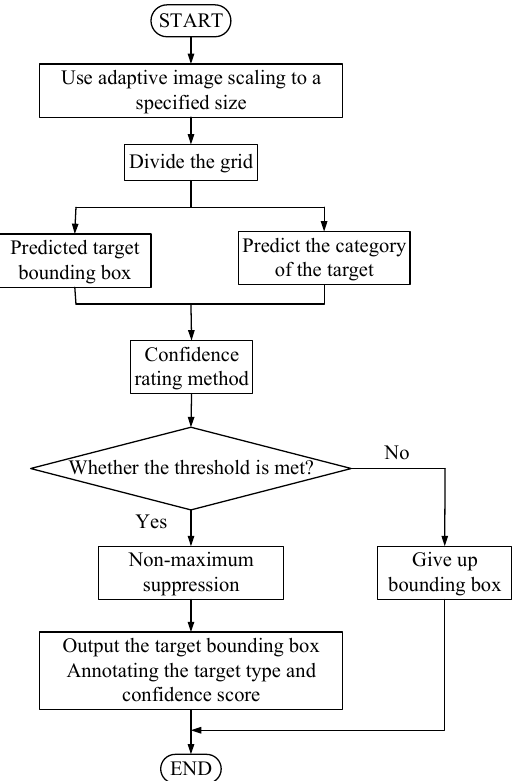
Figure 8. YOLOv5 target detection flow chart.